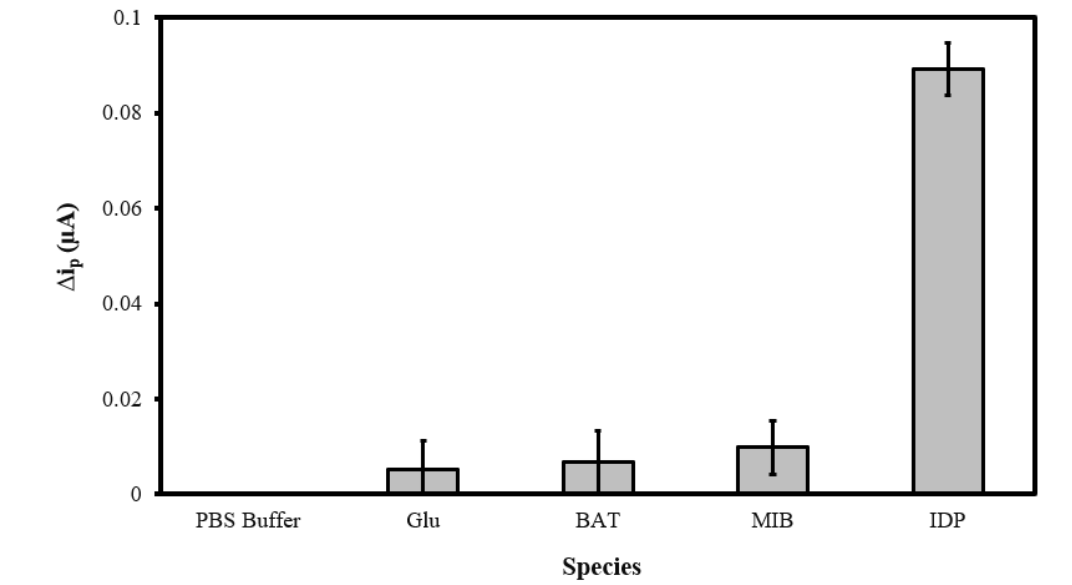
Figure 8. Peak DPV current (Δi p ) obtained from sequential analysis of 0.10 M PBS blank, 1.0 µM glucose (GLU), 1.0 µM bioallethrin (BAT), 1.0 µM methyl imazamethabenz (MIB), and 1.0 µM imidacloprid (IDP) in 0.10 M PBS using the MIP@CNT/CNC MN sensor.